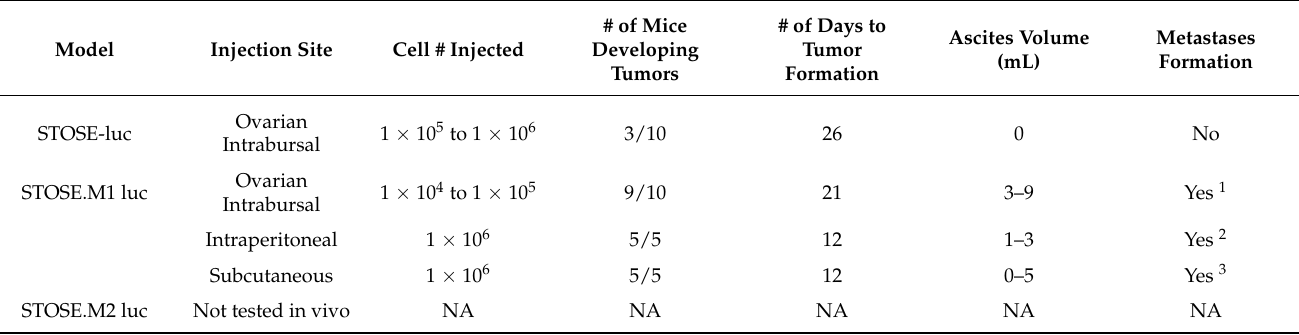
Table 1. Characteristics of the Ovarian Cancer Models that were